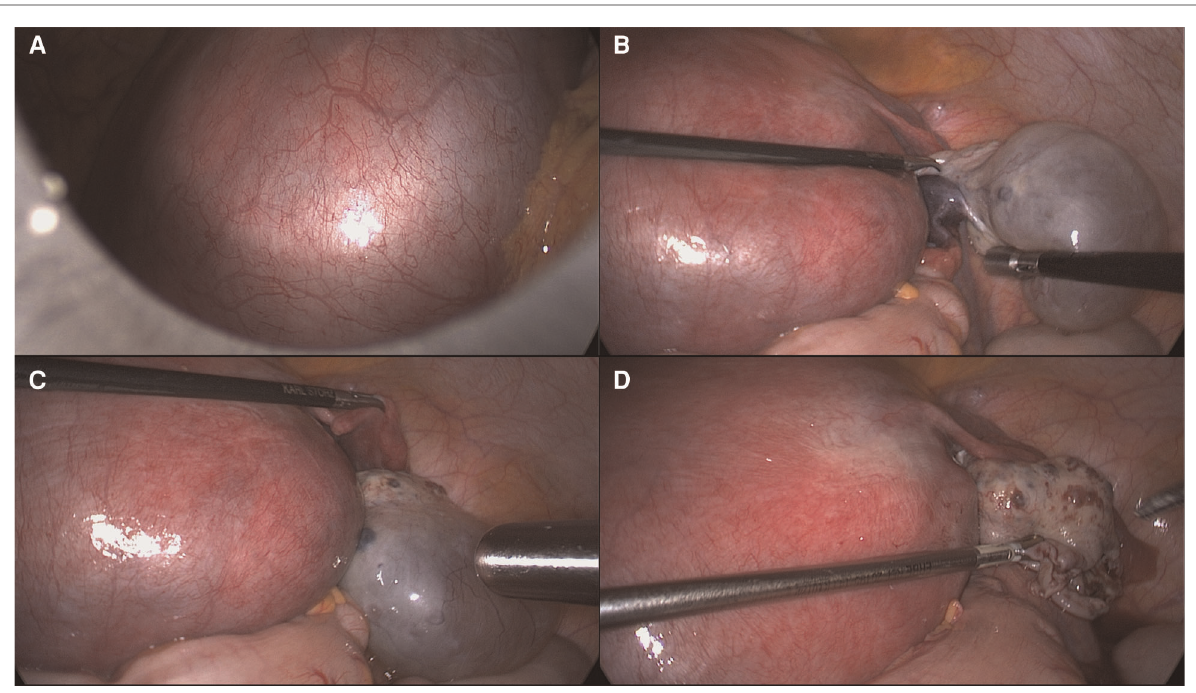
FIGURE 5 Laparoscopic right fallopian tube detorsion and ovarian cystectomy. ( A ) Enlarged uterus. ( B ) Right ovarian cyst measuring 6 cm×4 cm without torsion. But the right fallopian tube was rotated 90° counterclockwise and appeared to be dark red. ( C ) The right fallopian tube was reset and the blood fl ow was restored. ( D ) Reapproximation of ovarian